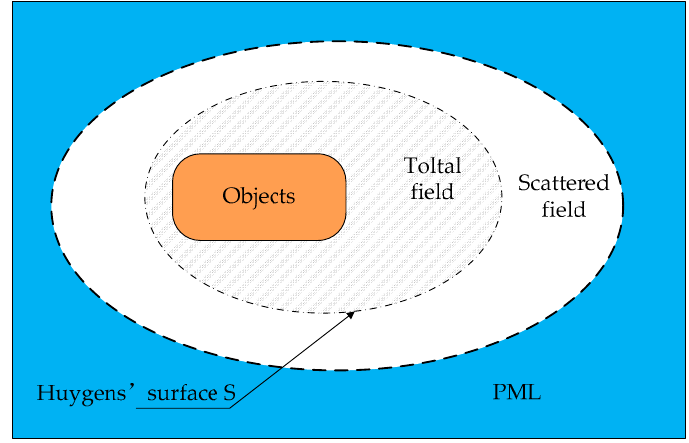
Figure 3. DGTD region.